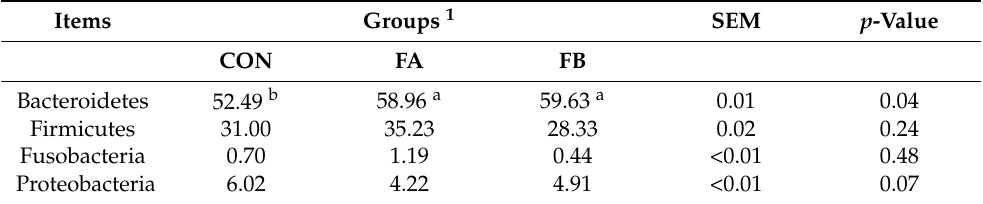
Table 8. Relative abundance of bacterial phyla in the cecal microbiota of layers in different groups.